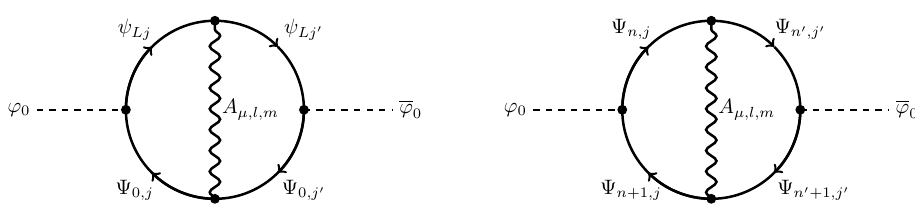
Figure 2 . Two-loop contributions to the scalar mass term which involve Kaluza-Klein modes of the vector